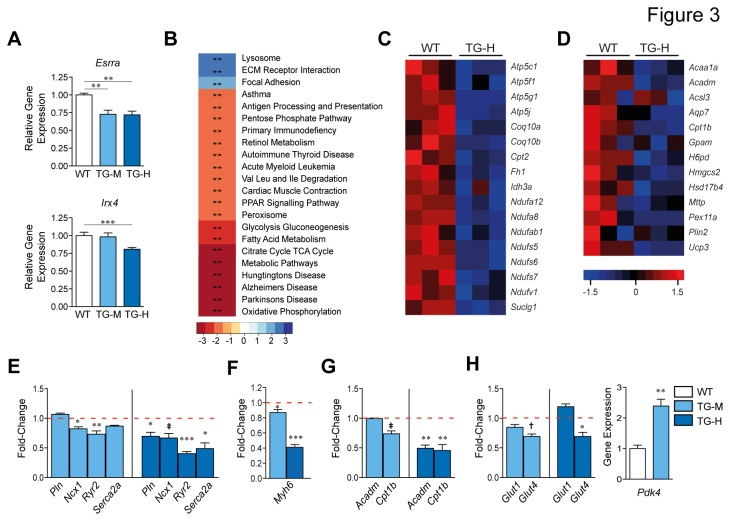
Enforced miR-22 expression impairs ERR/PPAR-dependent transcription in the heart.(A, E, F, G, and H) Cardiac mRNA expression levels for indicated genes were quantified by qPCR in TG-H, TG-M and WT mice aged (A) 5- or (E-G) 12-weeks old. In panels (E-H) bars represent expression normalized with WT set equal to 1.0 (n = 3-4). (B) Gene Set Enrichment Analysis (GSEA) of sorted gene lists obtained from the microarray detected significant expression shifts in the indicated KEGG pathways in TG-H hearts. **, P<0.005. (C and D) Transcriptome microarray-obtained expression profile heat maps for (C) ERR-regulated OXPHOS or (D) PPAR-regulated lipid metabolism genes in 12-week old TG-H and WT mice. Student t test, (E,F,G,H); or 1-way ANOVA with the Dunnett post hoc test, (A). *, P<0.05; **, P<0.01; ***, P<0.001; †, P=0.06; ‡, P=0.07.